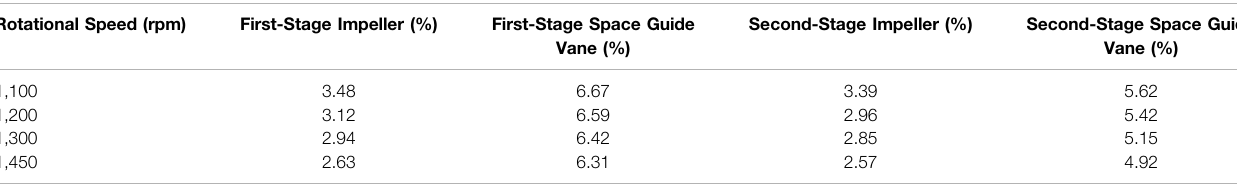
TABLE 5 | Particle volume concentration distribution under different speed